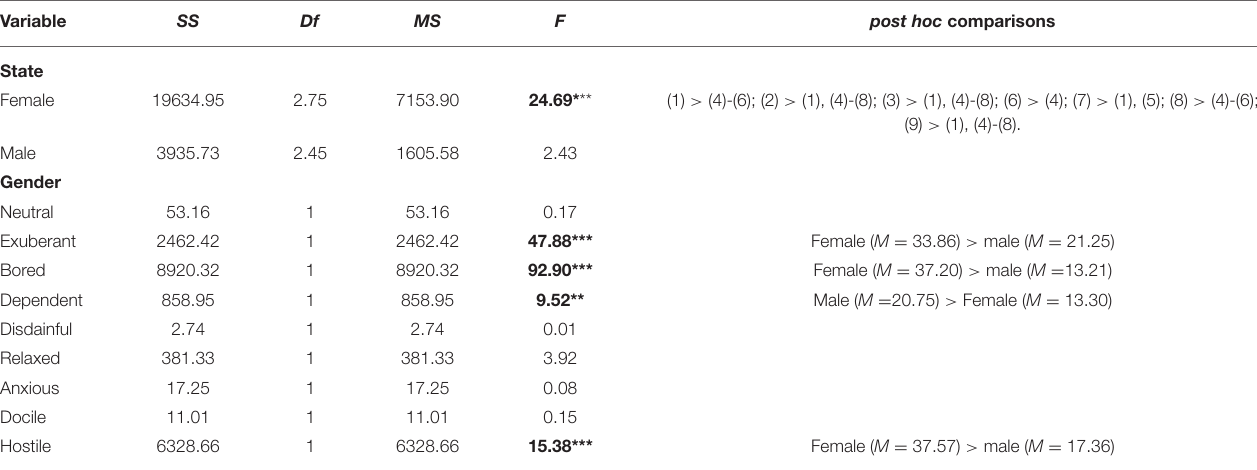
TABLE 6 | Simple main effect test of mixed design of gender and emotional states in Fo SD . Variable